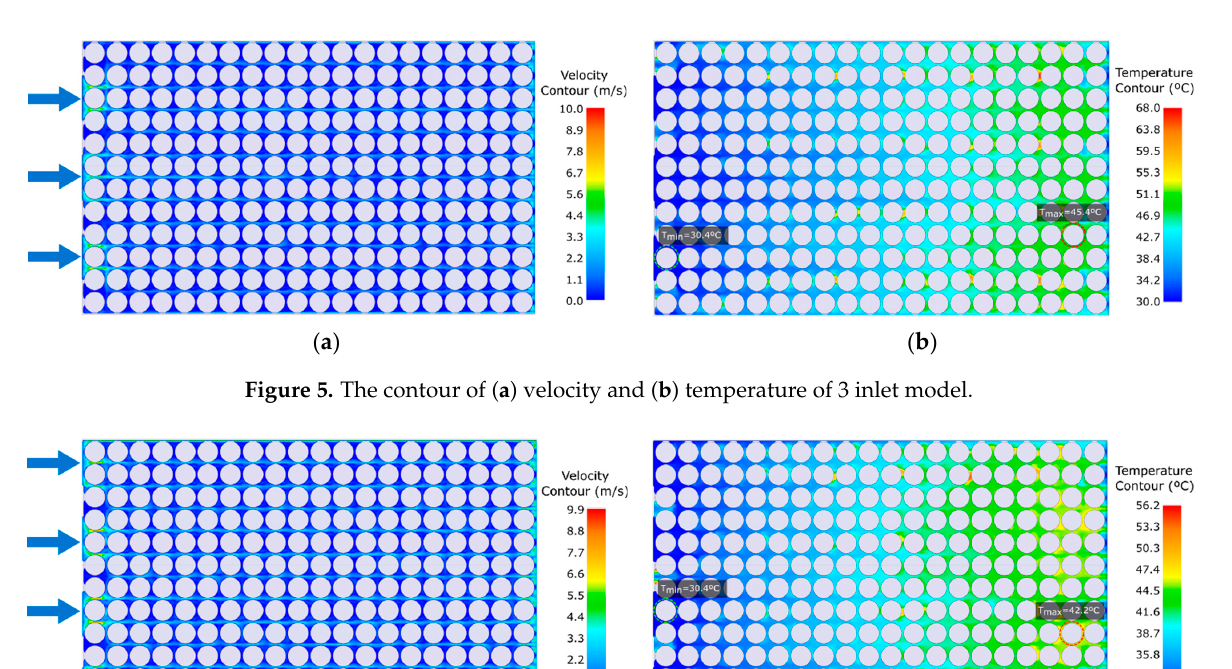
Figure 4. The contour of ( a ) velocity and ( b ) temperature of 2 inlet model.